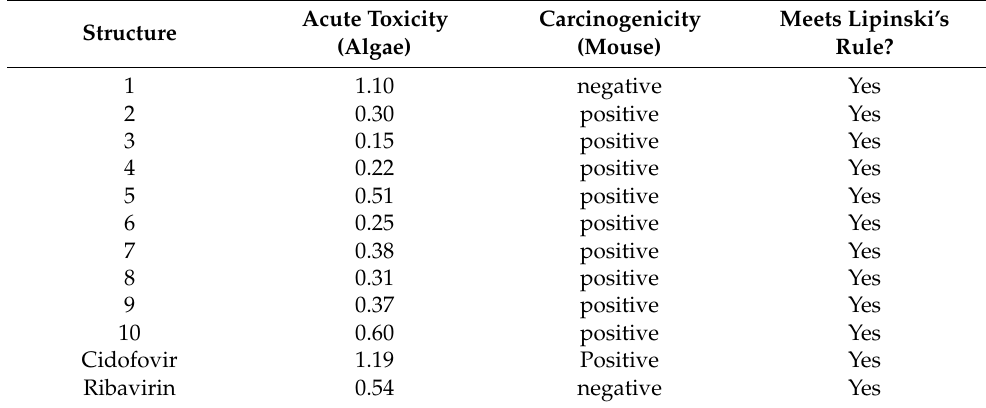
Table 2. Calculated values of acute toxicity, carcinogenicity (in mouse), and Lipinski’s rule of the compounds and